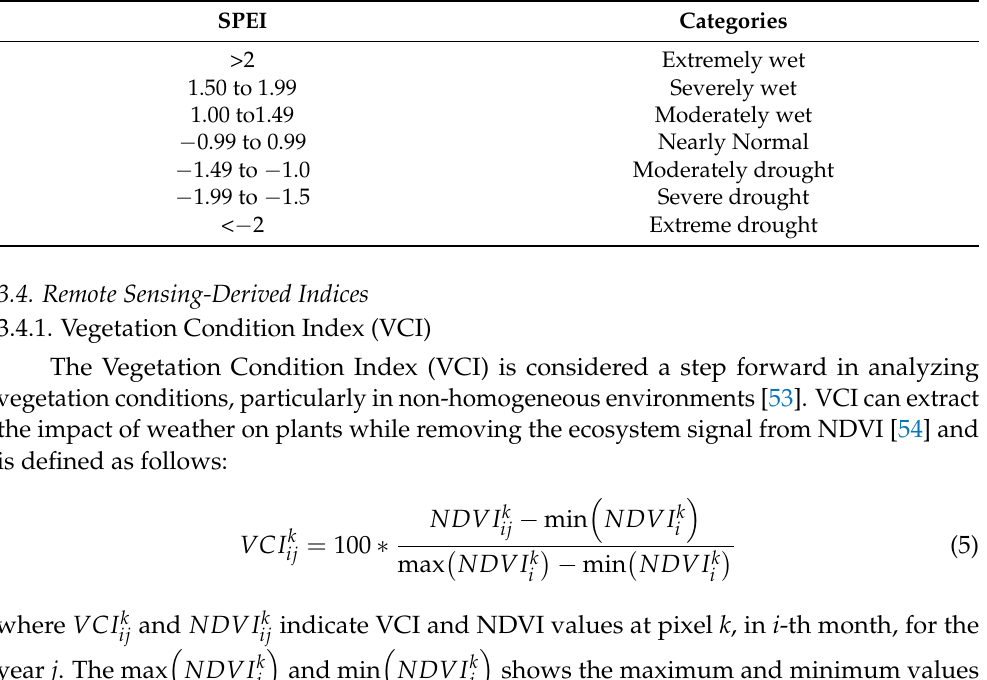
Table 2. Division of drought severity based on SPEI values (after